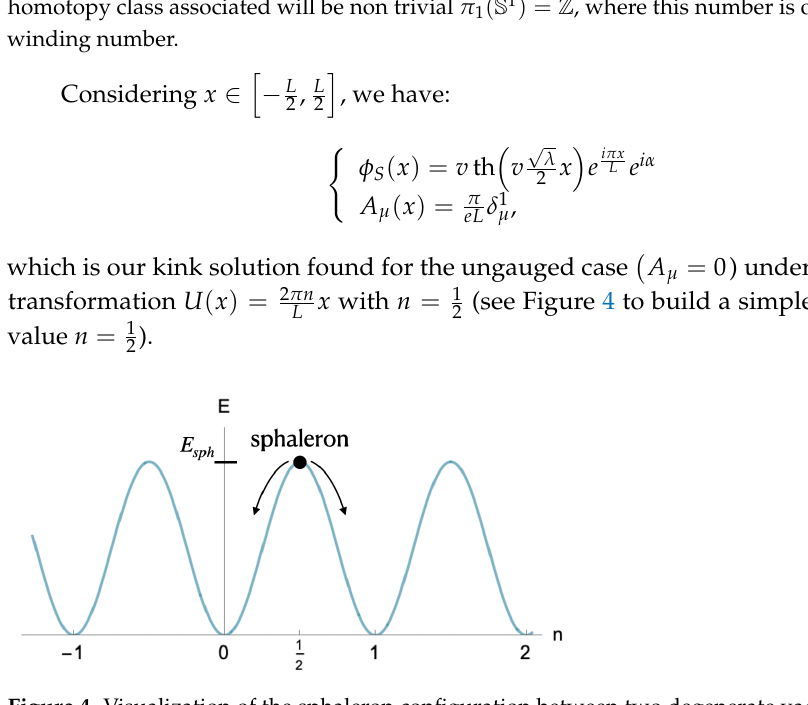
Figure 4. Visualization of the sphaleron configuration between two degenerate vacua. It corresponds to an unstable structure of the half integer Chern–Simons number. If the temperature is large enough, the sphaleron can be created and its instability can make it decay into one of the two vacua with n = 0 or n = 1 in our particular